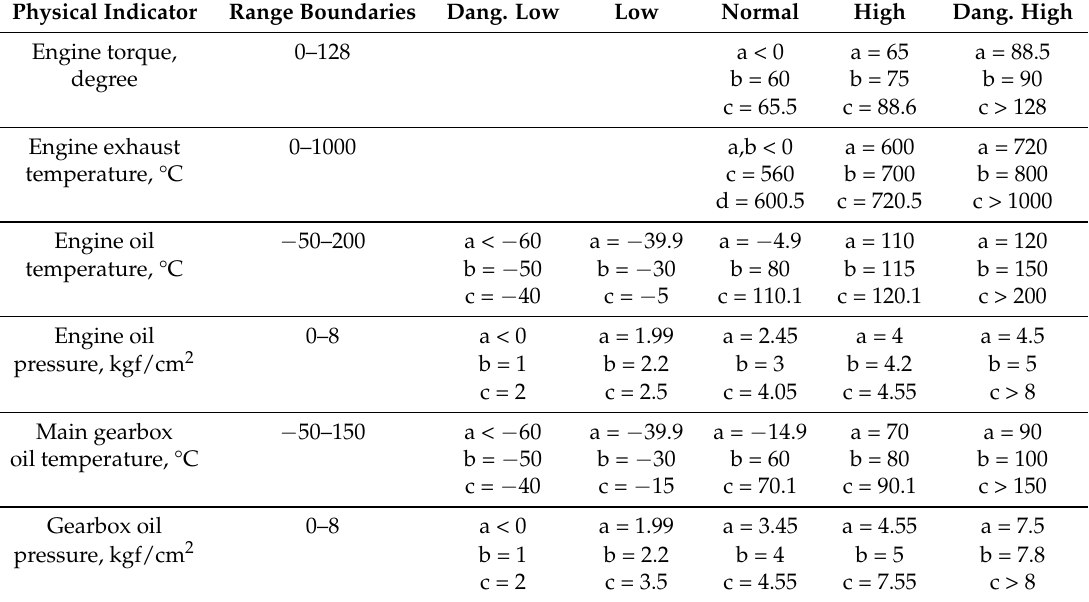
Table 2. Membership function